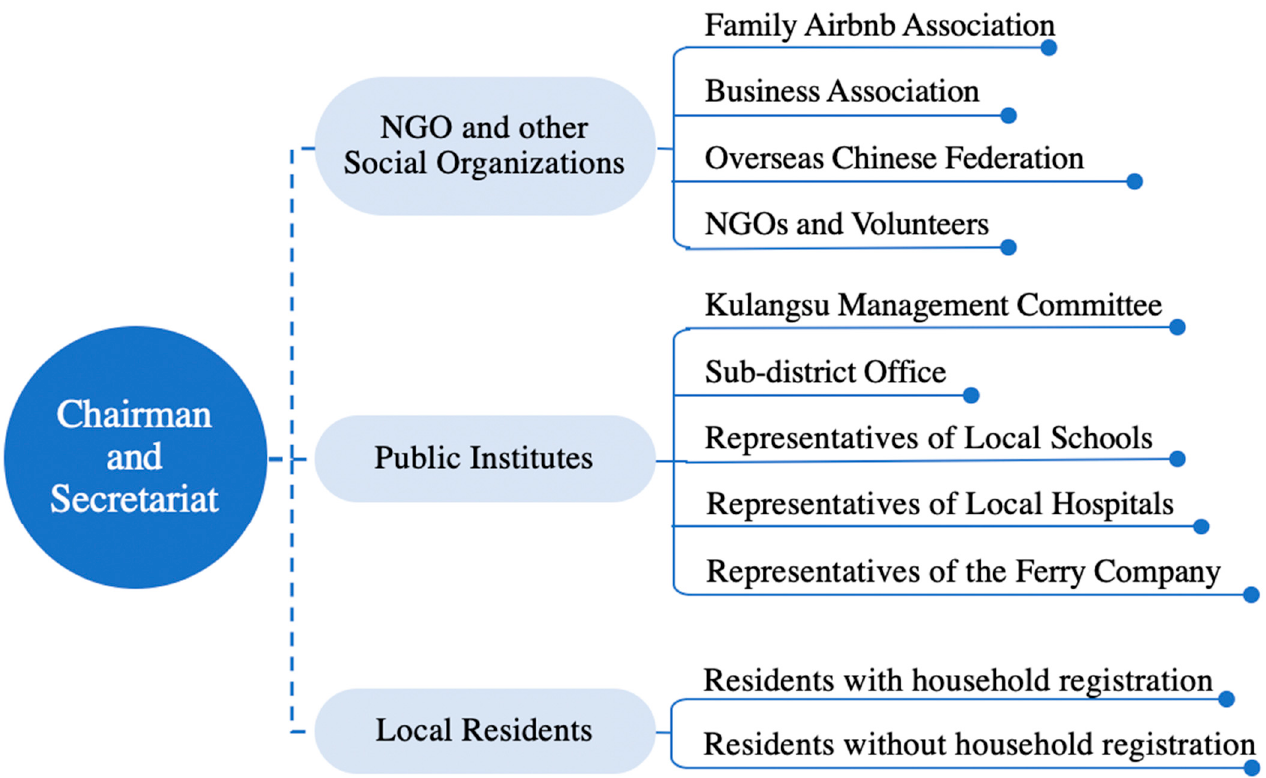
Figure 5. The structure of the stakeholders committee as the local public council (made by author).